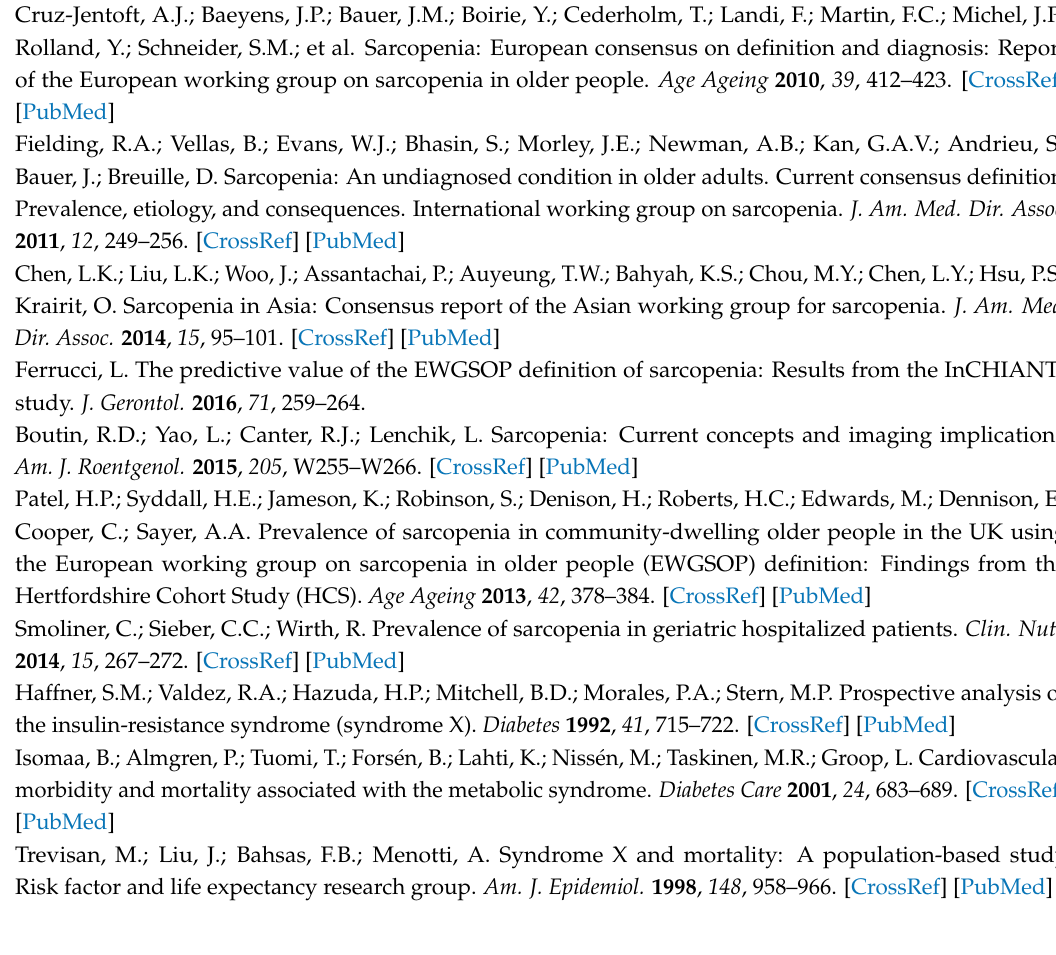
Table S1: The Preferred Reporting Items for Systematic Reviews and Meta-Analysis (PRISMA)